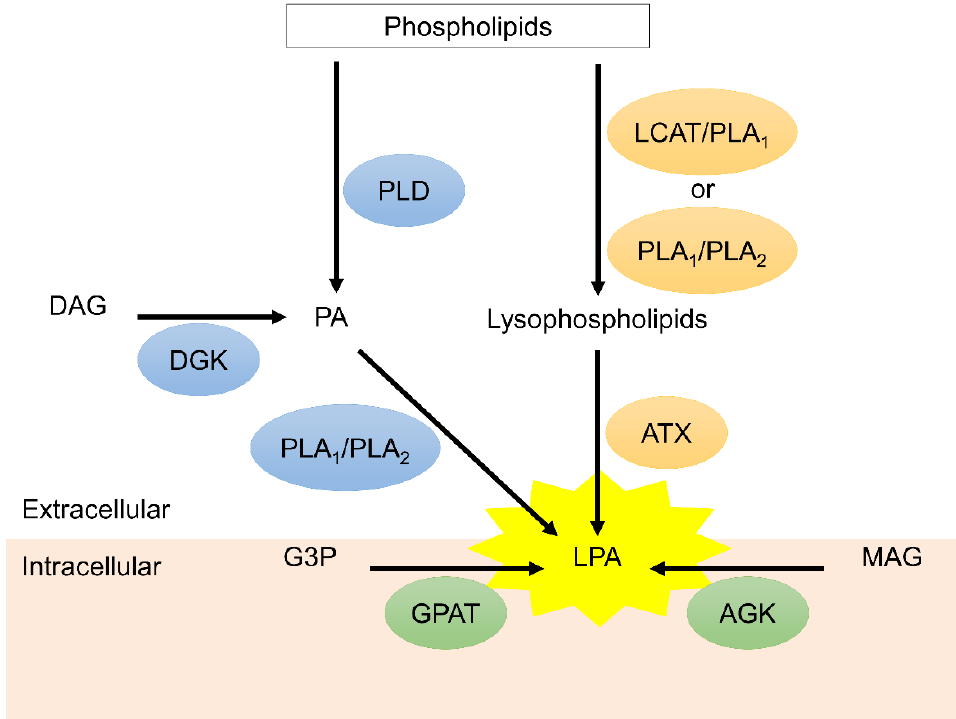
Figure 1. The biosynthesis of lysophosphatidic acid (LPA). Extracellular LPA is mainly synthesized by autotaxin (ATX) via conversion of lysophospholipids, which are hydrolyzed from phospholipids through lecithin-cholesterol acyltransferase (LCAT)/phospholipase A1 (PLA 1 ) or PLA 1 /PLA 2 mech- anism. Phosphatidic acid (PA) on the plasma membrane is another resource of extracellular LPA. PA can be generated from phospholipids and diacylglycerol (DAG) via phospholipase (PLD) and diacylglycerol kinase (DGK), respectively. PA is converted to LPA through PLA 1 and PLA 2 . On the other hand, monoacylglycerol (MAG) and glycerol 3-phosphate (G3P) on the mitochondria gener- ated intracellular LPA via acylglycerol kinase (AGK) and glycerophosphate acyltransferase (GPAT), respectively.